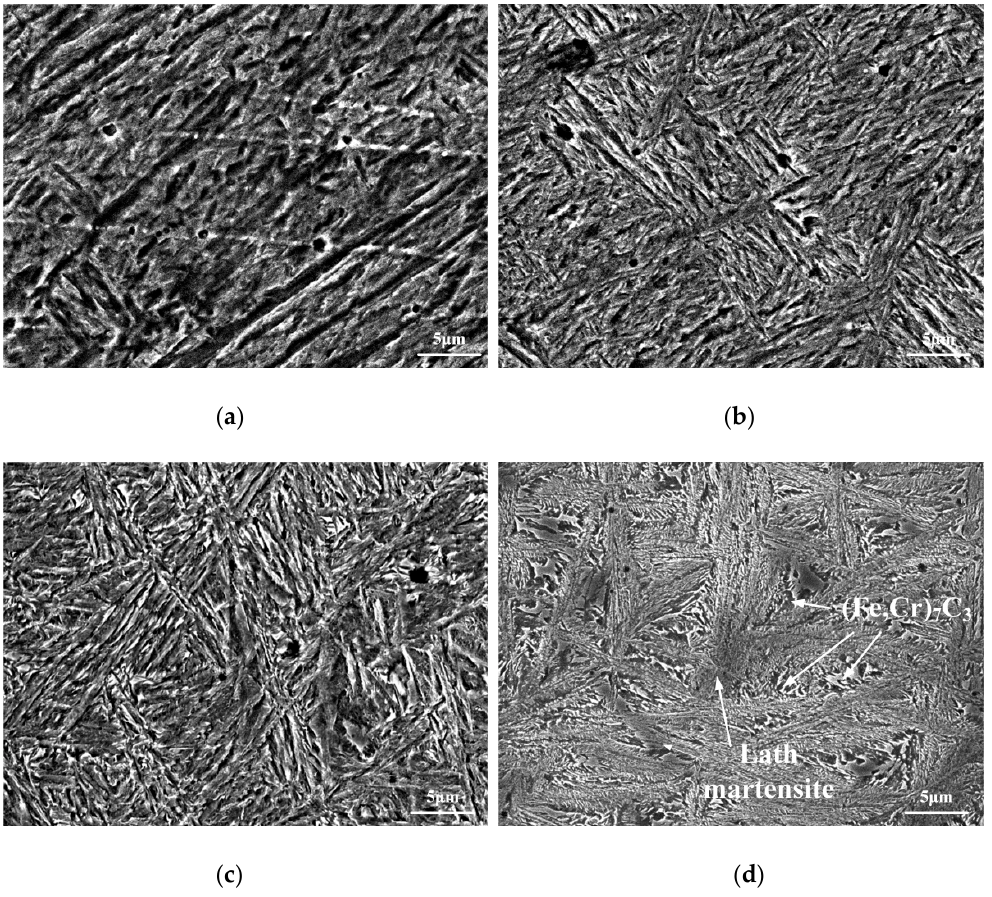
Figure 8. Martensite structure of weld zone of 42CrMo4/38MnVS6 laser welded joint: ( a ) single laser heat source; ( b ) 100 °C; ( c ) 200 °C; ( d ) 300 °C. heat source; ( b ) 100 ◦ C; ( c ) 200 ◦ C; ( d ) 300 ◦